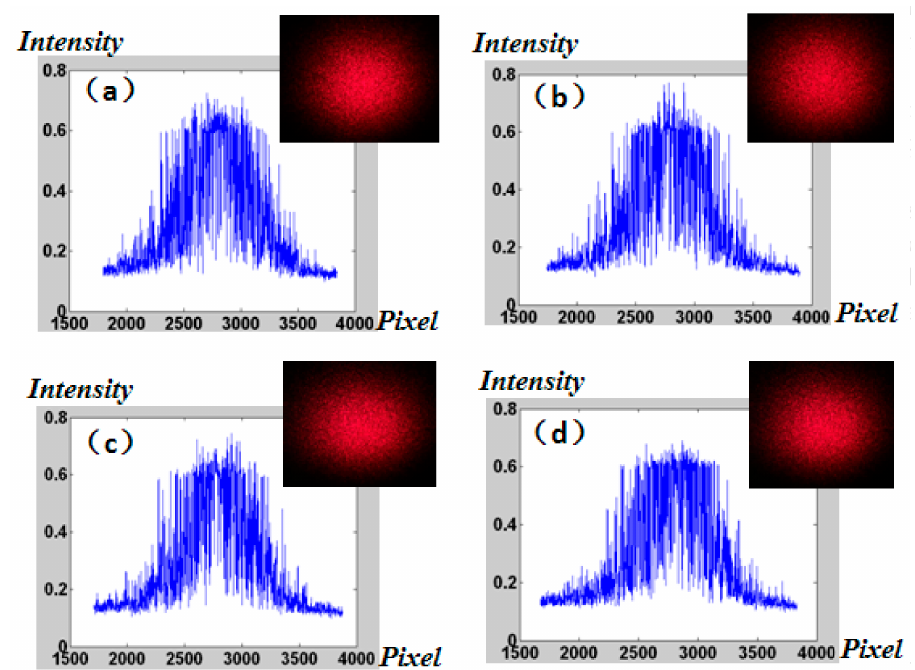
Figure 9. The random speckle patterns at different locations produced by prepared microwells: ( a ) up; ( b ) down; ( c ) left; ( d )